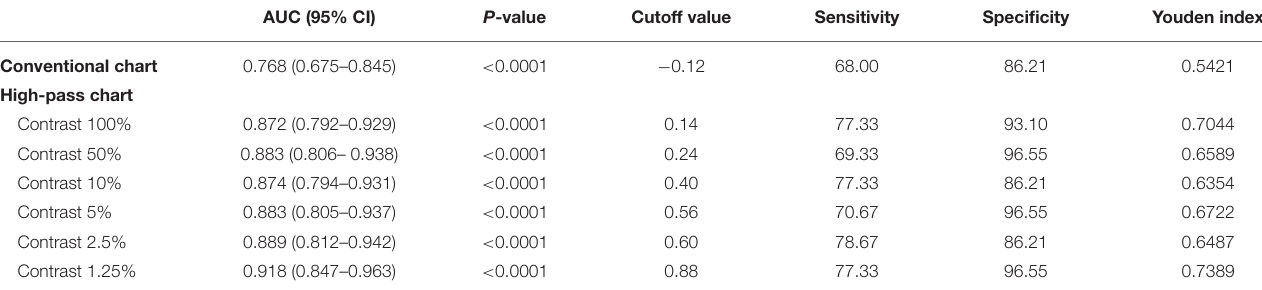
TABLE 4 | Receiver operating characteristic curve analysis of visual acuities between glaucoma patients with normal vison ( N = 75) and healthy controls ( N =